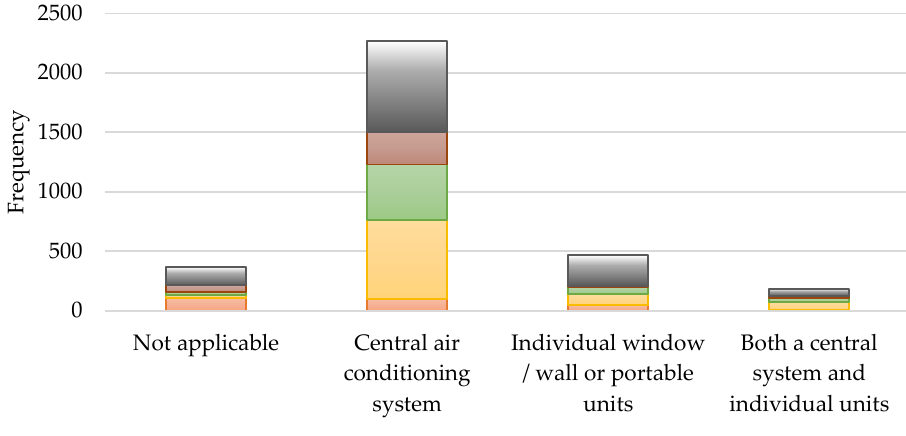
Figure 9. Type of main air conditioning equipment per climate zone (total n = 3288).